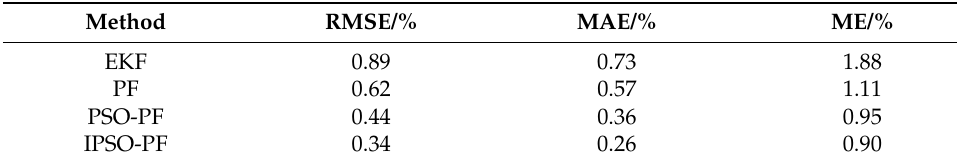
Figure 18. SOC Estimation Results and Errors of Different Driving Conditions. Table 6. Errors of US06 Driving Condition. Table 5. Errors of FUDS Driving Condition.